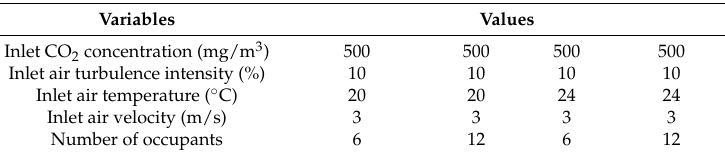
Table 1. Input conditions used in the CFD simulation.